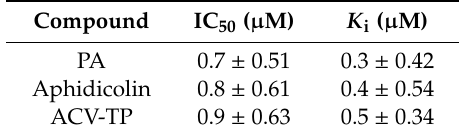
Table 3. Inhibitory activity of psoromic acid (PA), aphidicolin, and acyclovir triphosphate (ACV-TP) against HSV-1 DNA